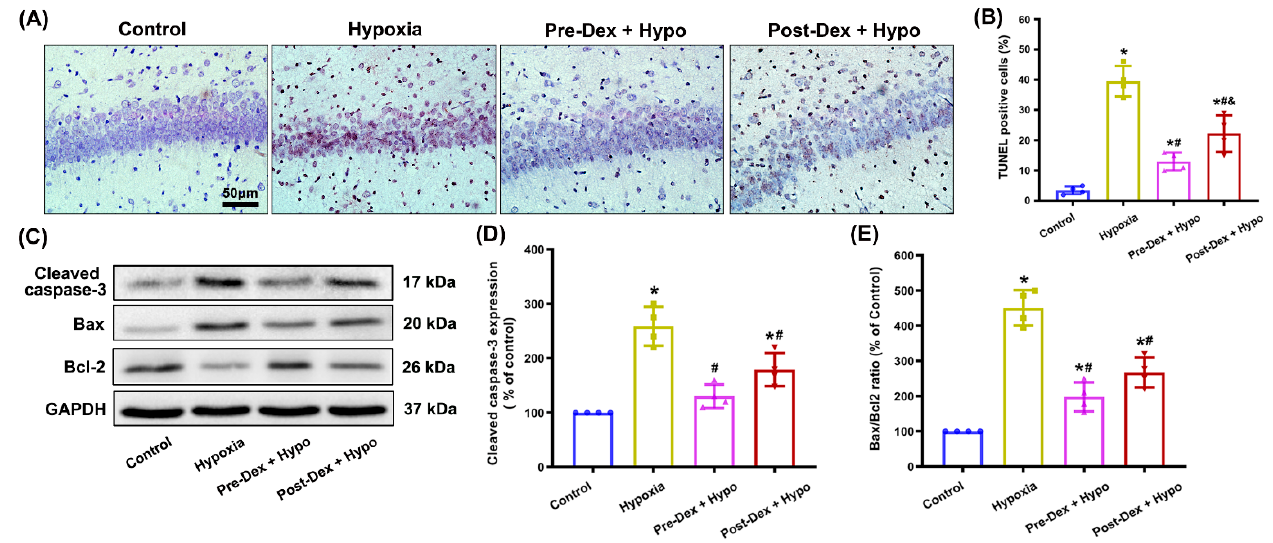
Figure 4. The effect of Dex on neuronal apoptosis in the hippocampus following neonatal hypoxia. ( A ) A TUNEL assay was used to evaluate neuronal apoptosis in the hippocampal CA1 region 1 d after neonatal hypoxia. ( B ) The apoptosis index (%) was calculated by dividing TUNEL-positive cells by the total number of all cells. ( C ) The levels of cleaved caspase-3, Bax, and Bcl-2 in the hippocampus were detected by Western blotting. ( D , E ) Quantitative analysis of the protein cleaved-caspase-3 ( D ) and Bax/Bcl-2 ratio ( E ). Results are expressed as mean ± SD ( n = 4 in each group). Each animal data point in the bar graph is also presented. * p < 0.05 versus the Control group; # p < 0.05 versus the Hypoxia group; & p < 0.05 versus the Pre-Dex group.